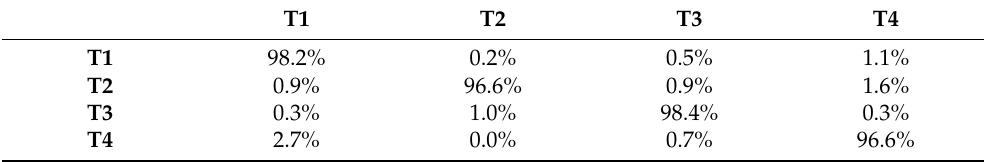
Table 2. Tone confusion matrix using semitone of mixed-gender based on SVM.